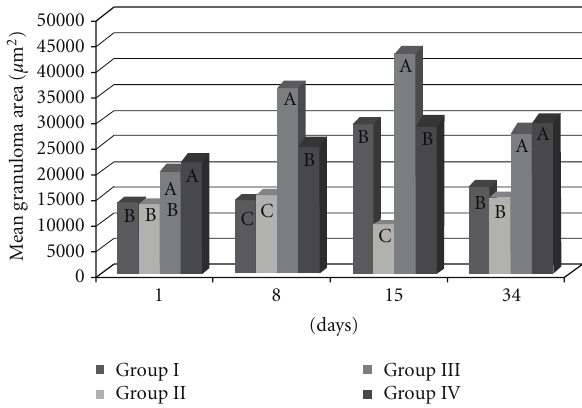
Figure 4: The mean granuloma area in the lungs of the mice that were inoculated with eggs of the S. mansoni BH (Group I) or SJ (Group II) strains and of those that were previously infected with the S. mansoni BH strain and then inoculated 8 weeks later with eggs from the S. mansoni BH (Group III) or SJ (Group IV) strains. The mice were euthanized 1, 8, 15, and 34 days after inoculation with the eggs. At each time point, the means depicted with the same letter do not di ff er significantly ( α = 0 .